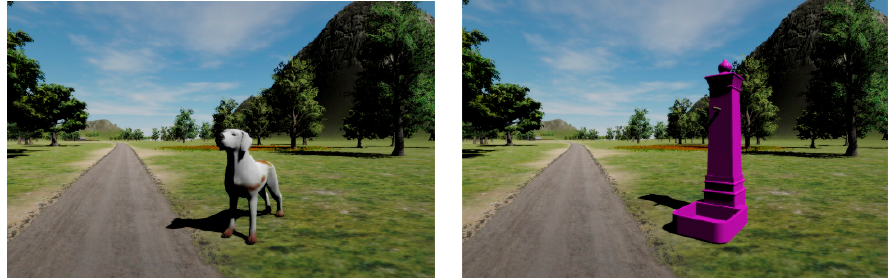
Figure 2. Examples of the two types of targets: a dog and a colored fountain.